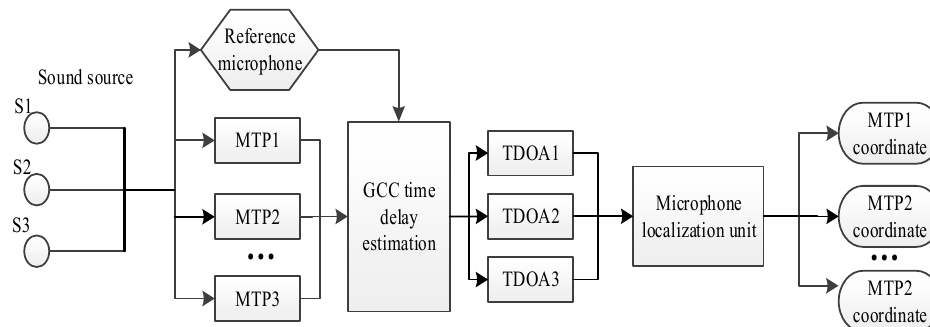
Figure 4. Microphone localization processing chain. MTP: microphone to be positioned.